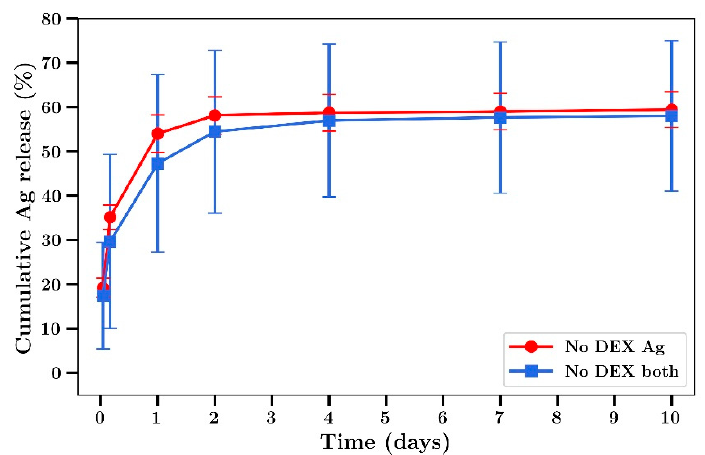
Figure 6. Time course of Ag release from Palacos bone cement films (no dextran) loaded with Ag alone or Ag plus gentamicin. (Silver loaded at 0.8% and gentamicin at 0.8% w/w ) ( n = 4). Gentamicin release from bone cement films in the absence of dextran containing ei-